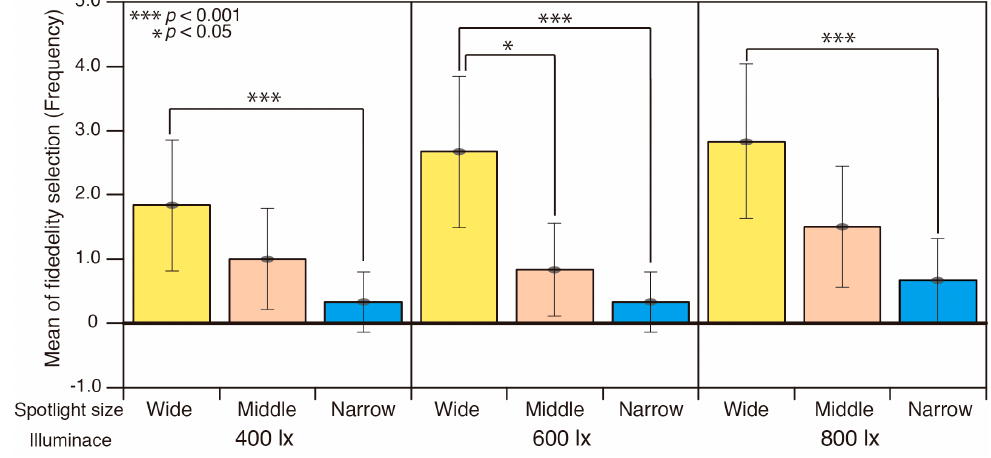
Figure 7. Result of the fidelity selection for each diffuseness and illuminance conditions.